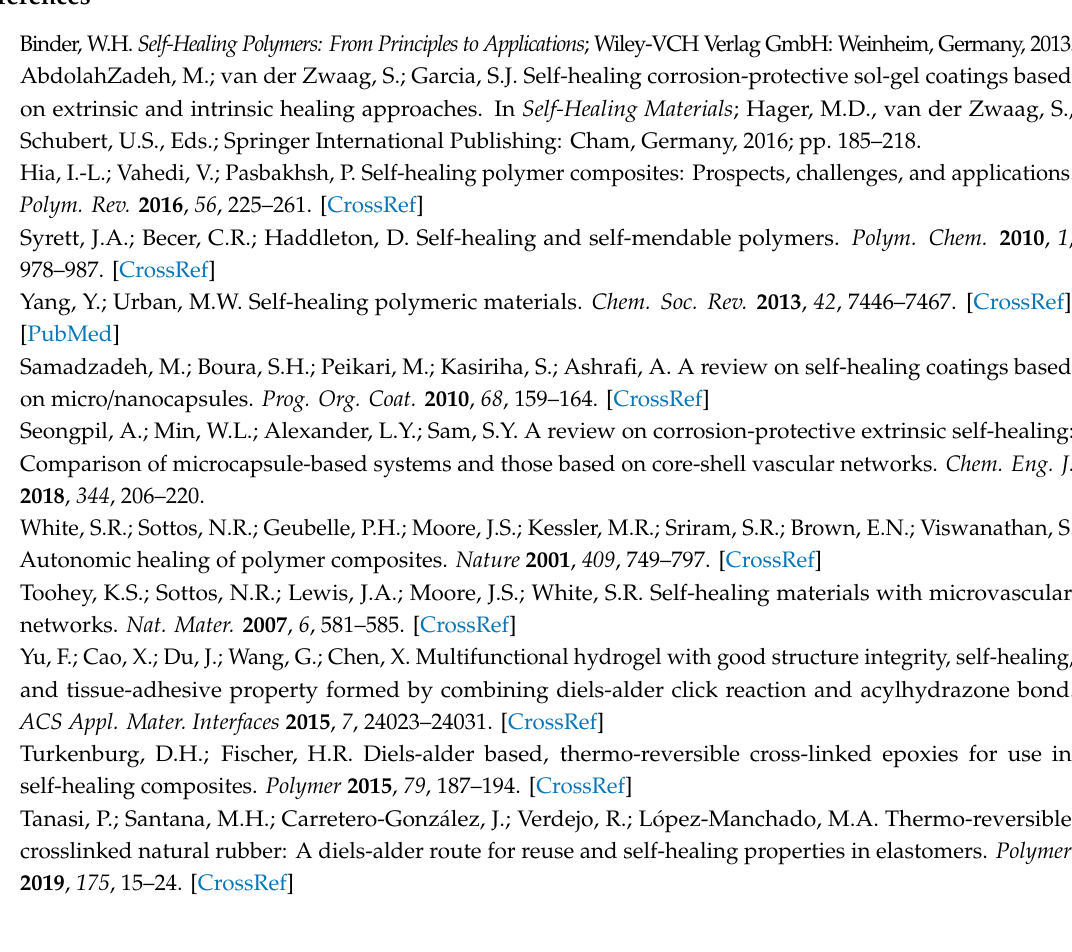
Figure S2: Five successive loading-unloading cycles of the film prepared from TFPM-PDMS-25000, Figure S3: The successive loading-unloading cycles of the samples of TFPM-PDMS-25000 and BTA-PDMS-25000 in compression tests, Figure S4. Cyclic stress-strain tests of TFPM-PDMS-25000 in compression tests with di ff erent relaxation times, Figure S5: Stress-strain curves of TFPM-PDMS-25000 films healing for di ff erent times at 0 ◦ C, Figure S6: Healing e ffi ciencies of TFPM-PEA-25000 with di ff erent healing durations at 0 ◦ C, Figure S7: Photographs illustrating the macroscopic cutting-healing-stretching procedure of TFPM-PDMS-25000 films at 25 ◦ C, Figure S8: The energy-absorbing properties of TFPM-PDMS-25000 polymer at 100% strain, Table S1: Key mechanical properties of TFPM-PDMS-25000 Film (100 mm min − 1 ), Table S2: The energy-absorbing e ffi ciency ω of TFPM-PDMS-25000 for di ff erent strains at room temperature, Video S1: The fast elastic recovery experiment of TFPM-PDMS-25000, Video S2: The plastic deformation of TFPM-PDMS-25000 after 30 min of compression, Video S3: The stretching and deformation of